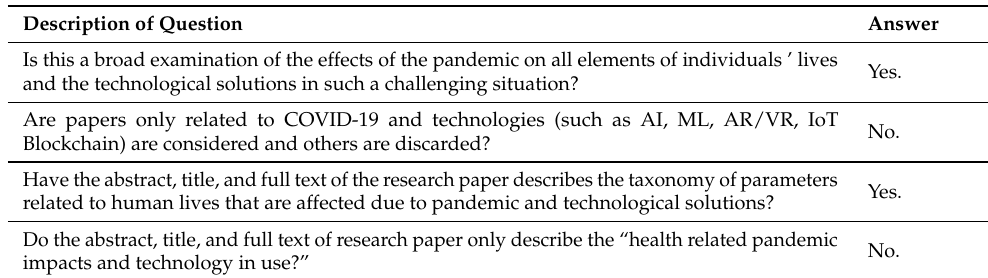
Table 2. Quality hiding